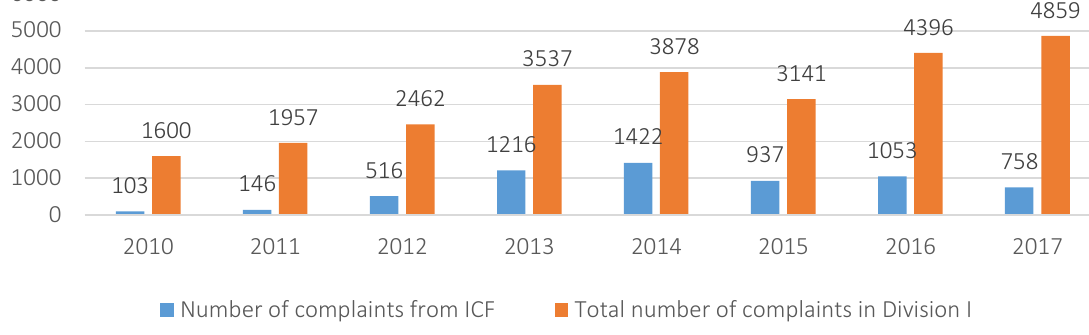
Figure 2. Number of complaints affecting insurance to security institutions in Poland